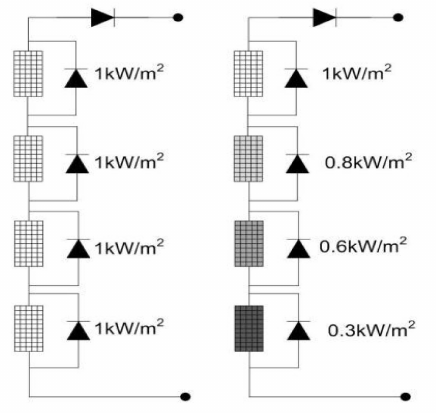
Figure 2. Partial and complex partial shading